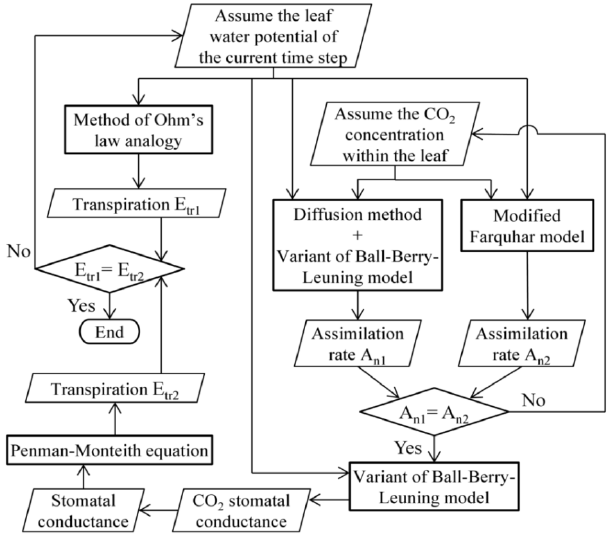
Figure 7. The computational representation of soil–plant– atmosphere water and carbon fluxes in the VIC + model. Consis- tency between carbon and water exchanges across the leaf surface, and between water transport from the soil, through plant transport tissues and into the boundary layer, are enforced by means of an iterative algorithm. Plant hydraulic properties (via the Ohm’s law analogy) and stomatal responses thus simultaneously constrain both transpiration and assimilation. Rectangles indicate calculation pro- cesses; parallelograms represent variables. From Luo et al.